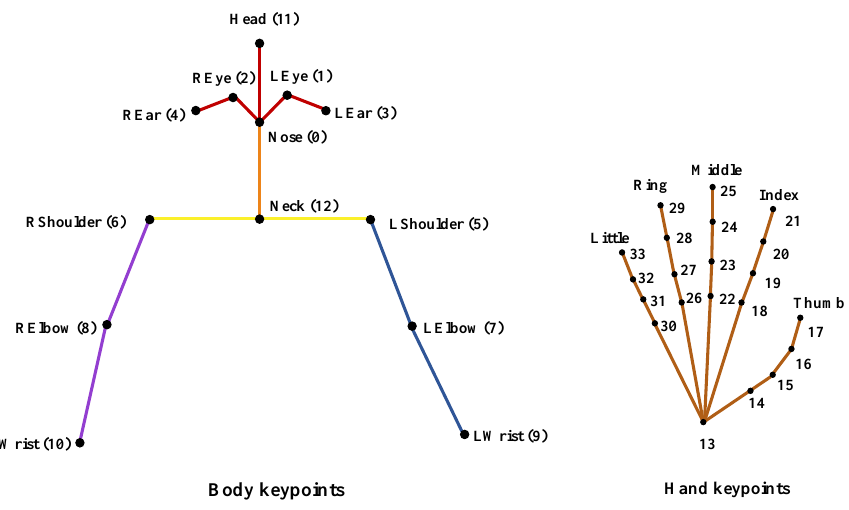
Figure 3. Location and number of the keypoints. We used 55 keypoints and excluded the keypoints of the lower body. Hand keypoints included both left and right hands. Then, we divided each normalization part by color.